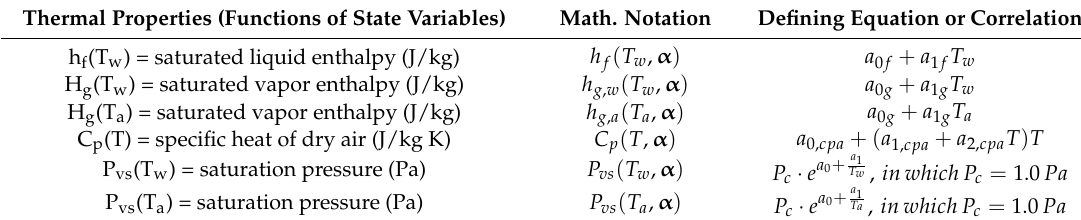
Table B3. Thermal Properties (Dependent Scalar Model Parameters).